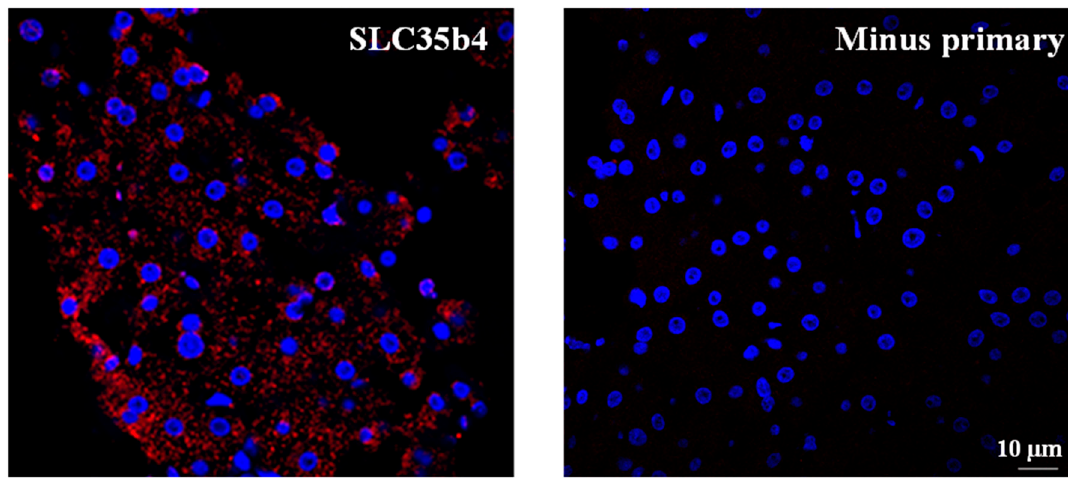
Figure 5. Immunostaining for SLC35B4 in normal liver tissue. Immunostaining was detected using Alexa fluor555. Cell nuclei were counterstained with Hoechst 33342 dye.